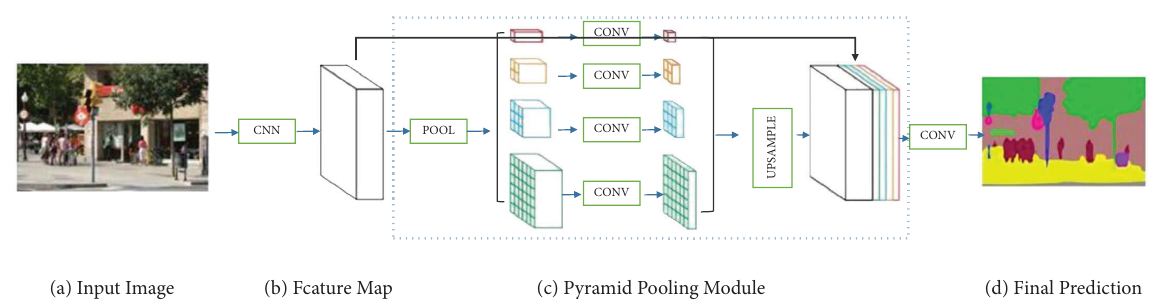
Figure 7: Video semantic segmentation. (a) Input image. (b) Feature map. (c) Pyramid pooling module. (d) Final